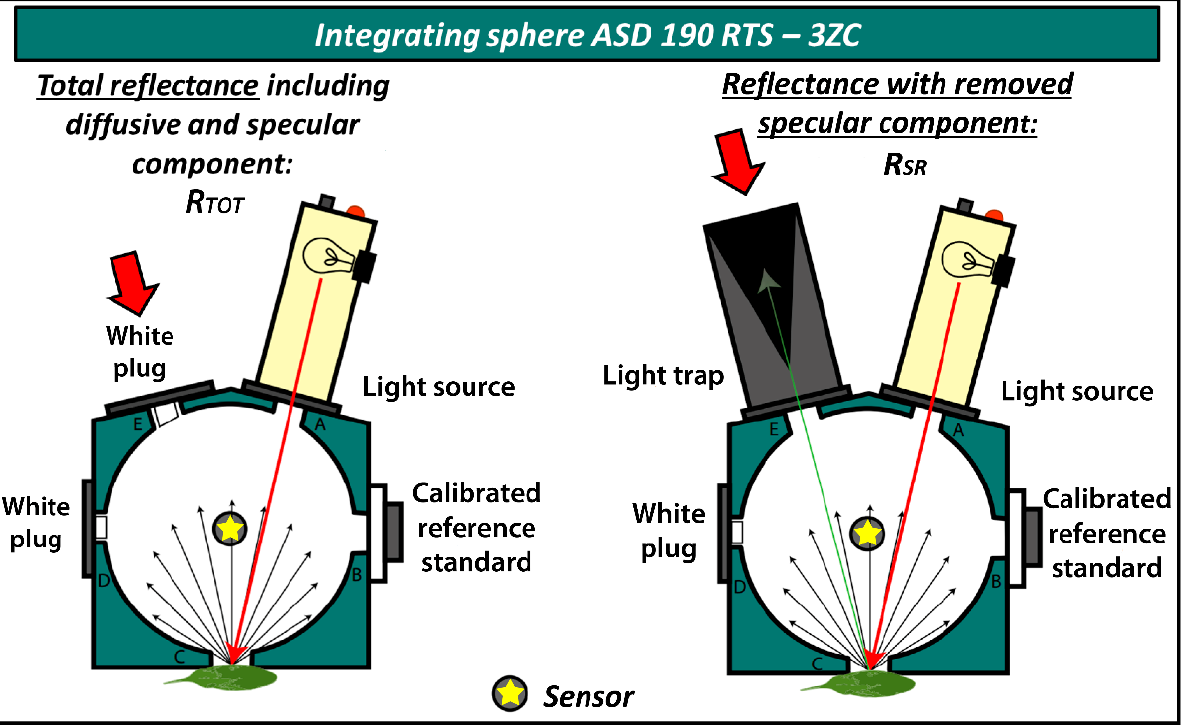
Figure 3. Measuring leaf reflectance by two integrating sphere set-ups: total reflectance (R TOT ) and reflectance with specular component removed (R SR ). Yellow star in grey circle represents the optical cable sensor, which was placed on the surface of the integrating sphere.